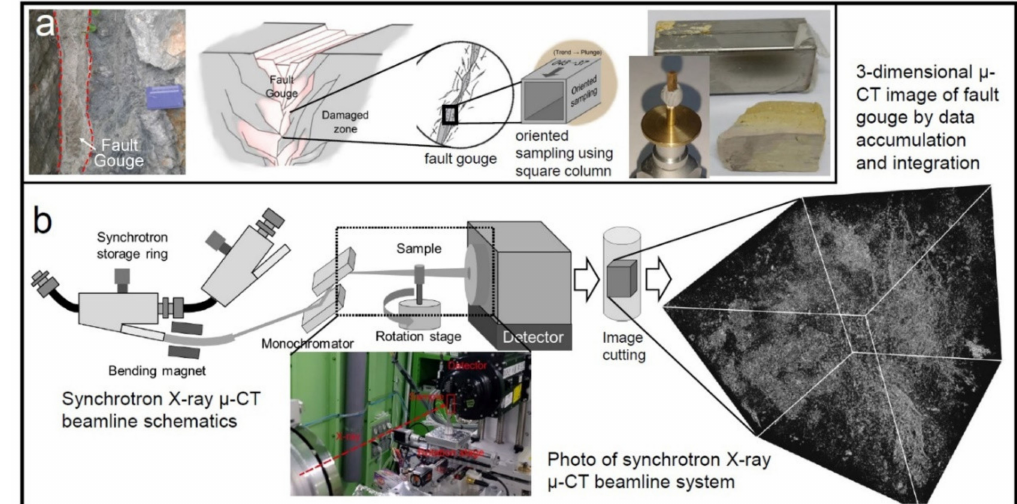
Figure 3. Schematic diagram of sampling and computational tomography (CT) imaging. ( a ) Photo of sampling site, oriented sampling process from the fault gouge in the fault zone, BK-1 sample, and sample cut to suitable size. ( b ) Schematic diagram showing the process of acquiring a 3D image of a sample from the 6C µ -CT beamline at the Pohang Accelerator